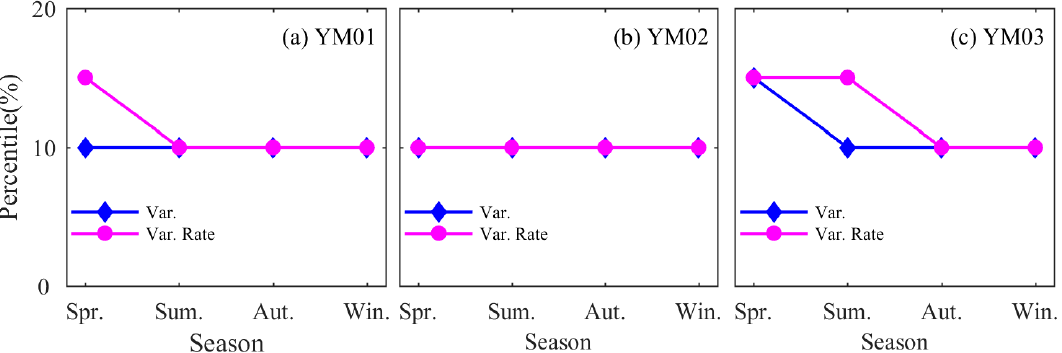
Figure 4. Optimal percentile statistics of PWV variation amount and variation rate at each station.